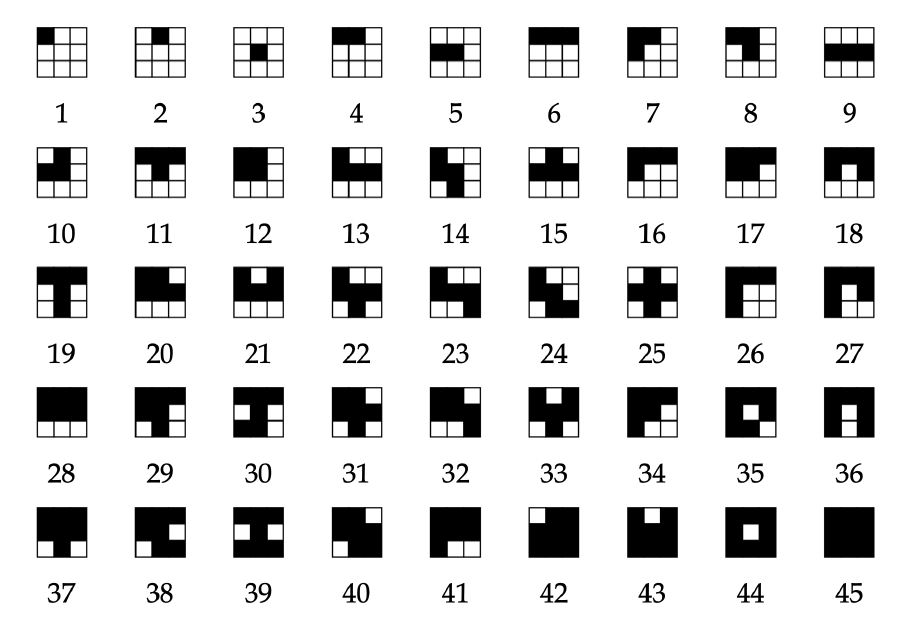
Figure 6: Congruence classes of direction relation matrices